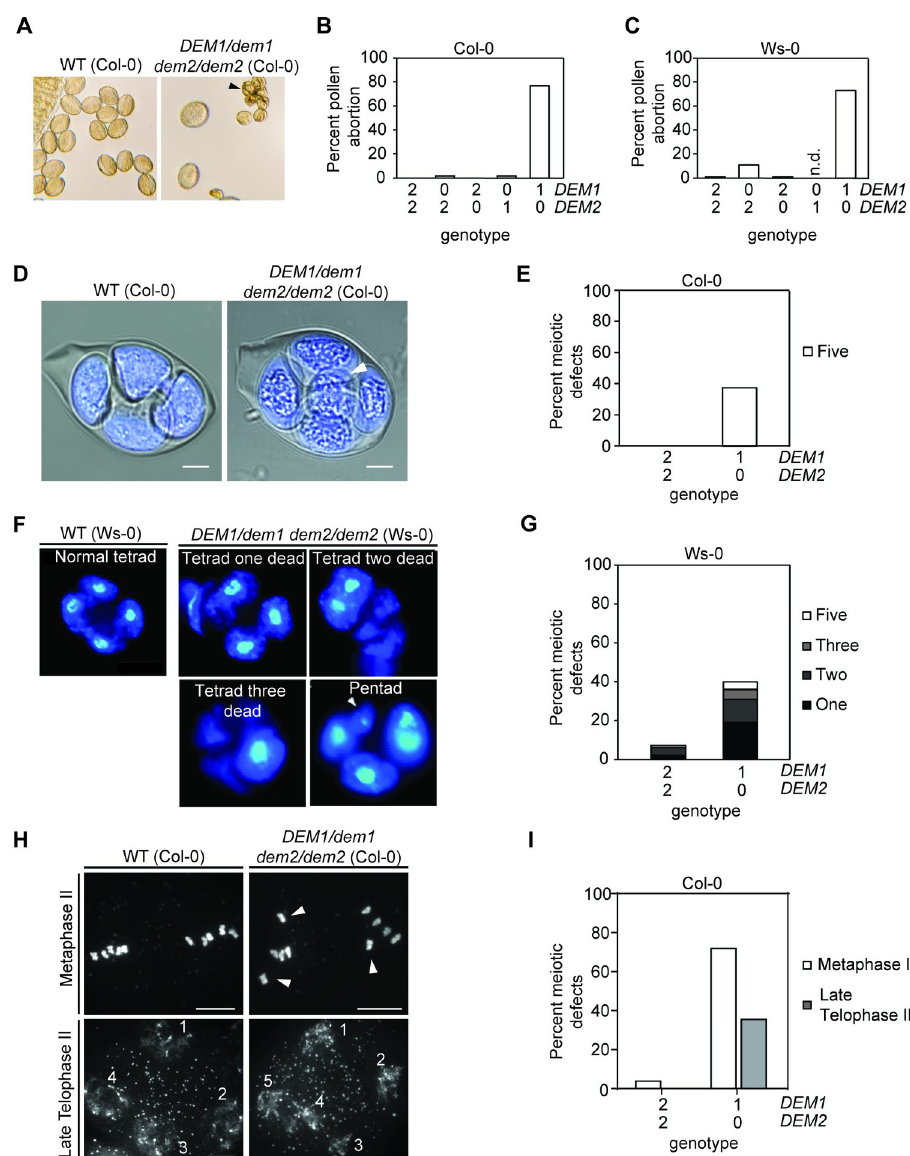
Fig 5. DEM1 and DEM2 are required for normal pollen development and male meiosis in Arabidopsis . (A) Phenotype of pollen produced by wild-type (WT) and DEM1/dem1 dem2/dem2 plants in the Col-0 genetic background. Dead pollen grains are indicated by a black arrowhead. (B-C) Percentage of aborted mature pollen in WT and dem genotypes for the Col-0 (B) and Ws-0 (C) genetic backgrounds. At least 700 mature pollen in total were assayed, involving at least three separate plants for each genotype. n.d., not determined as dem1/dem1 DEM2/dem2 were not recovered in the Ws-0 genetic background. (D) Confocal image of DAPI-stained tetrads, combined with a DIC imaging to view membrane structures, shows an excess of meiotic products (i.e. a pentad) in a DEM1/dem1 dem2/ dem2 plant (ecotype Col-0); an extra product of meiosis of diminished size is highlighted by the white arrowhead. Bar = 5 μ m. (E) Percentage abnormal tetrads produced by WT and DEM1/dem1 dem2/dem2 plants in the Col-0 background. At least 80 meiotic events were scored, involving at least three separate plants for each genotype. (F) DAPI-stained defective male tetrads of DEM1/dem1 dem2/dem2 plants in ecotype Ws-0 showing one to three dead microspores, and an extra microspore of diminished size in a pentad (white arrowhead). (G) Percentage of defective tetrads in WT and DEM1/dem1 dem2/dem2 plants of ecotype Ws-0. At least 200 tetrads were assayed for each genotype. (H) DAPI-stained meiotic chromosome spreads revealed misaligned chromosomes (white arrowheads) away from the metaphase plate at metaphase II in DEM1/dem1 dem2/dem2 male meiocytes, and also shown is an example of five daughter cells produced at telophase II in DEM1/dem1 dem2/dem2 male meiocytes (ecotype Col-0). (I) Percentage of male meiocytes showing defects at metaphase II (misaligned chromosomes) and late telophase